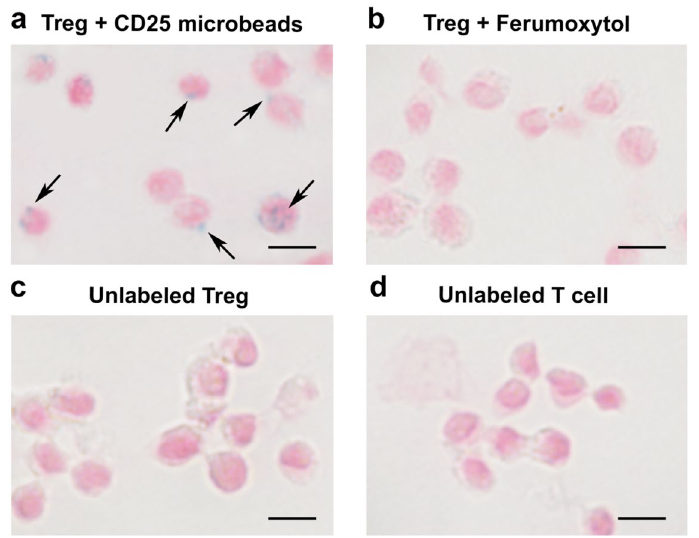
Figure 4. Confirmation of CD25 microbead intracellular uptake by Tregs. Regulatory T cells labeled overnight with 10 μl CD25 microbeads (45 μgFe/ml) exhibit positive intracellular Prussian blue staining ( a, arrows). Tregs labeled with ferumoxytol overnight ( b ) do not internalize the contrast agent. Unlabeled control Treg ( c ) and T cells ( d ) do not exhibit